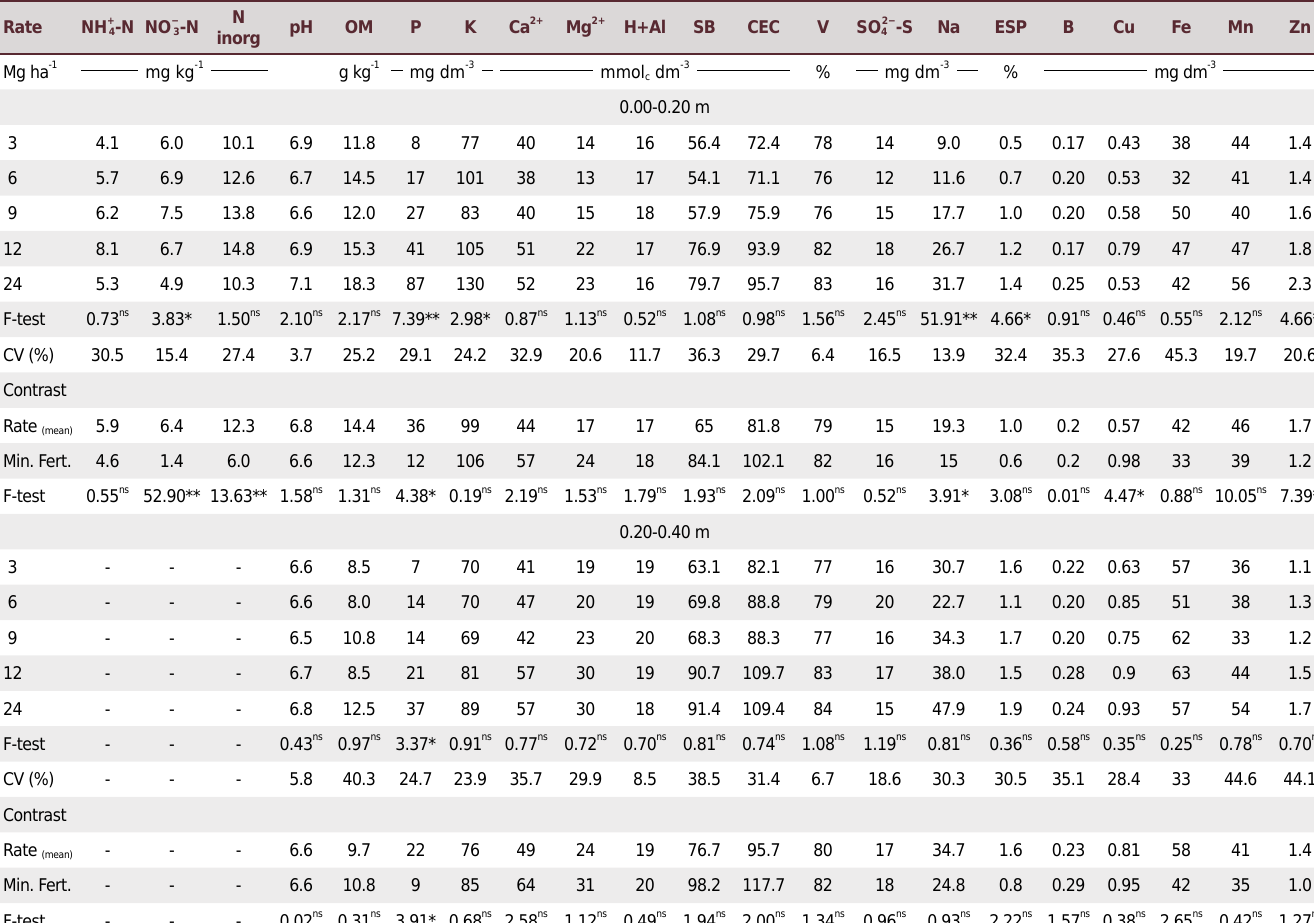
Table 4. Chemical properties of a Haplic Luvisol at 0.00-0.20 and 0.20-0.40 m depths, in 2014, and analysis of